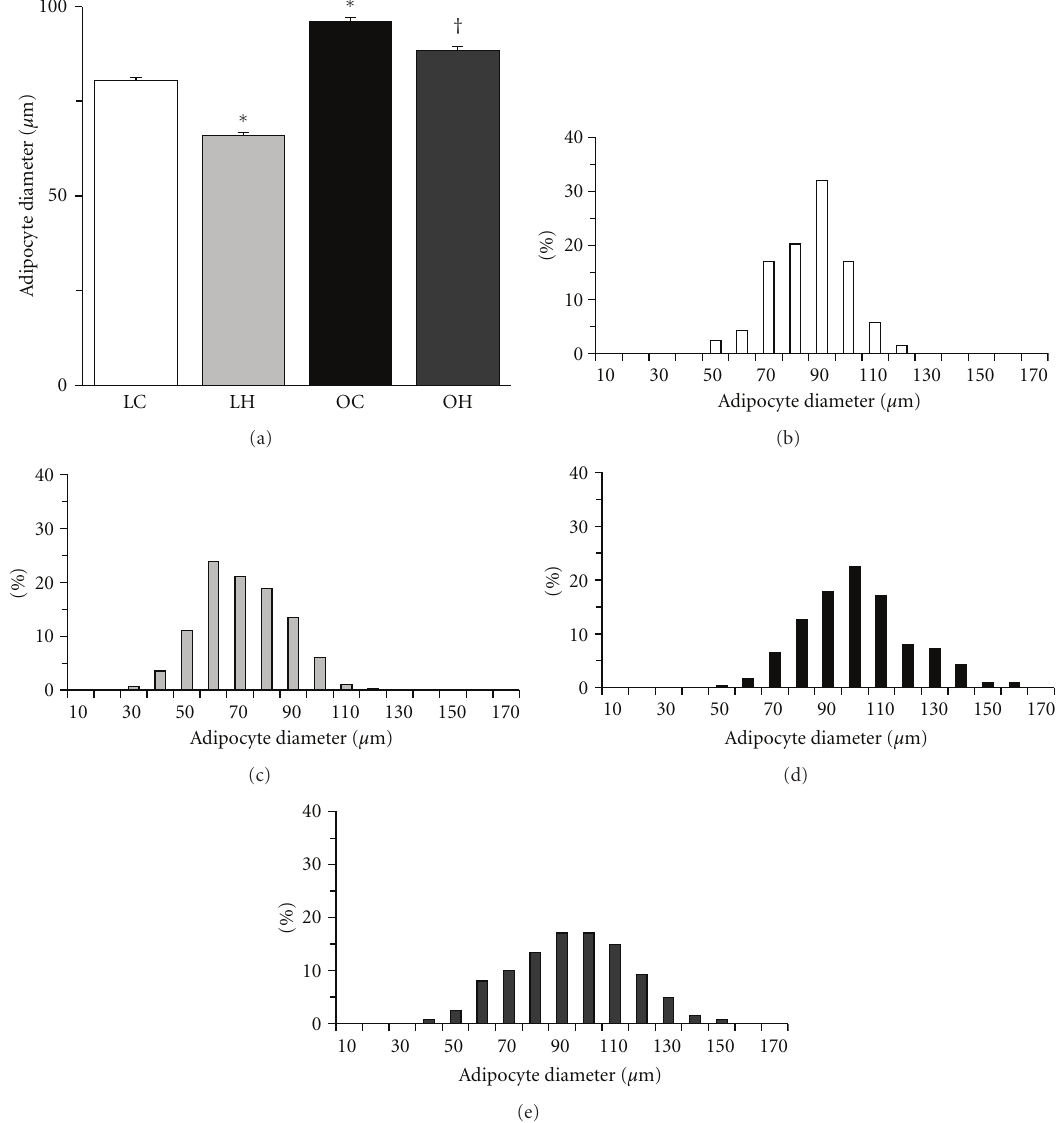
Figure 8: Diameter of adipocytes (a) and distribution of adipocyte size ((b) LC group; (c) LH group; (d) OC group; (e) OH group). The values of adipocyte diameter are presented as the mean ± SEM. ∗ and † are significantly di ff erent from the LC and OC groups, respectively, at P < 0 . 05. In each adipose tissue, over 100 adipocytes were